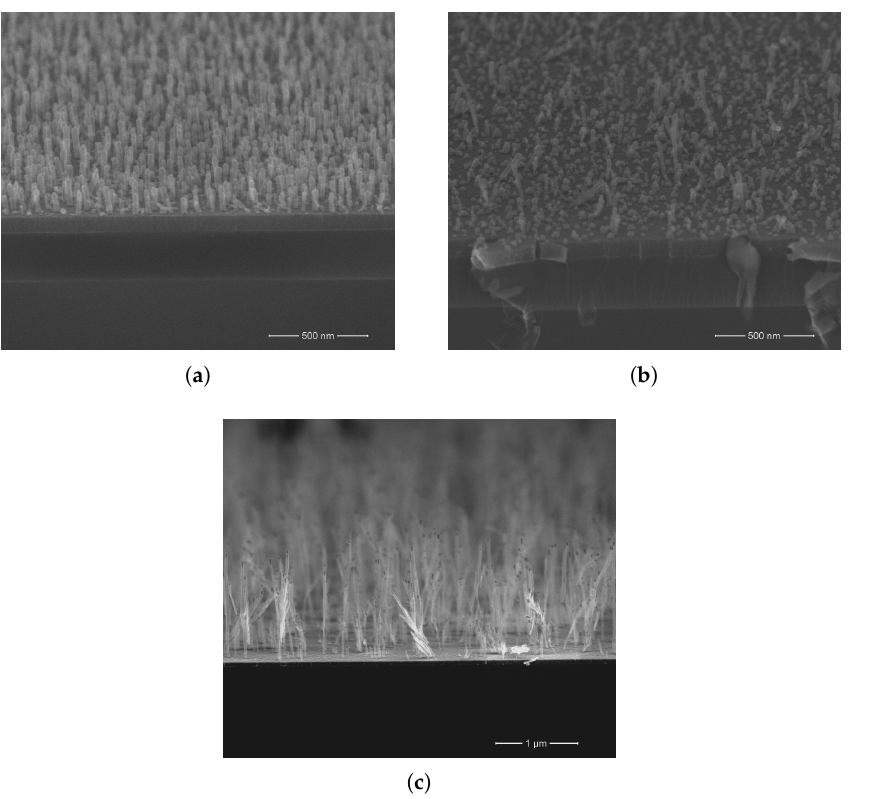
Figure 8. Cross-section micrographs of VA-CNTs grown at ( a ) 700 ◦ C with a two-minute H 2 plasma treatment step and a 30-min CH 4 :NH 3 (80:40) plasma step; ( b ) 700 ◦ C with a two-min H 2 plasma treatment step and a 120-min CH 4 :NH 3 (80:40) plasma step; ( c ) 800 ◦ C with a five-minute NH 3 thermal annealing step and a 300-min CH 4 :NH 3 (70:50) plasma